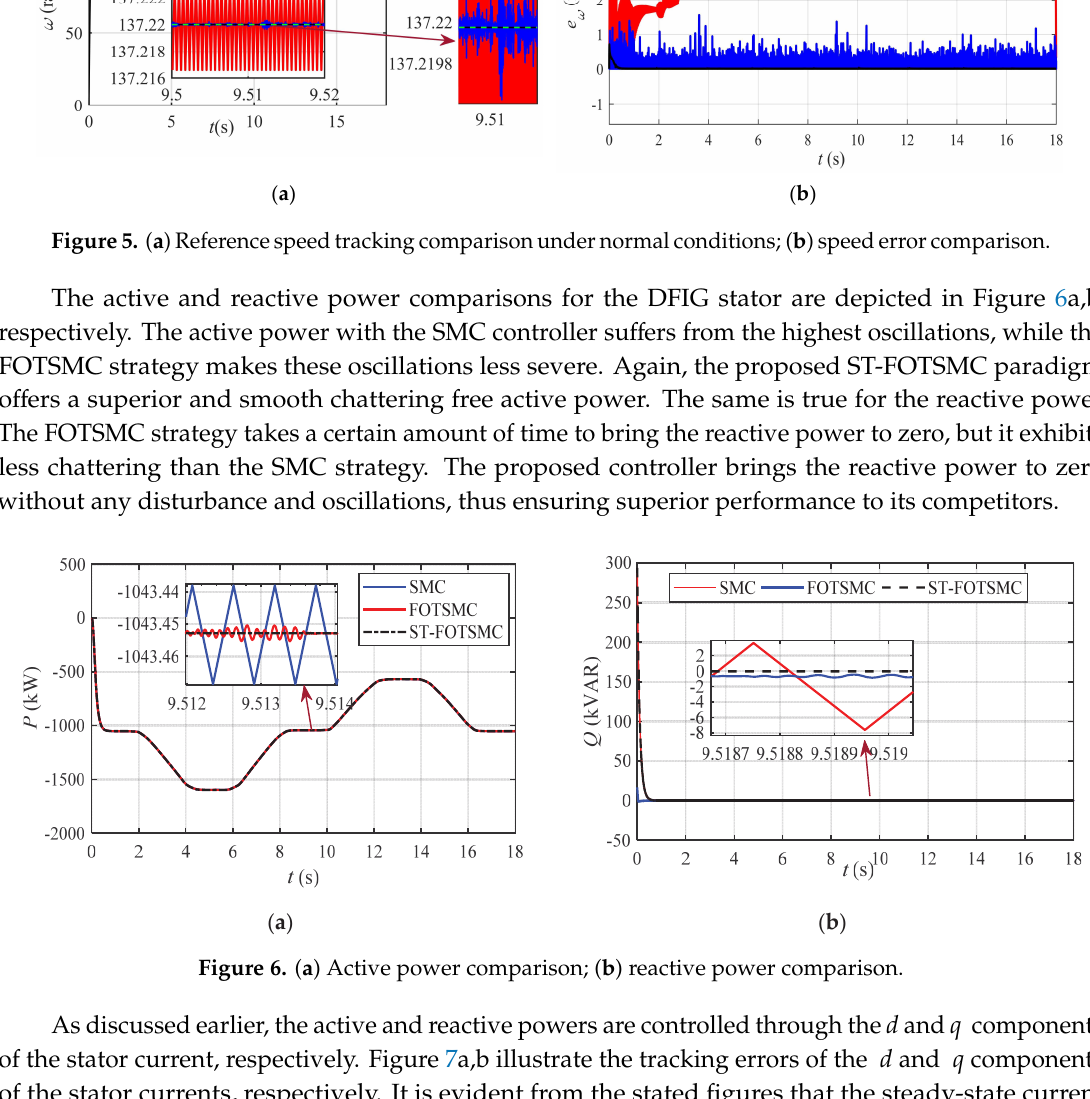
Figure (cid:561) 5. (cid:561) ( a ) (cid:561) Reference (cid:561) speed (cid:561) tracking (cid:561) comparison (cid:561) under (cid:561) normal (cid:561) conditions; (cid:561) ( b ) (cid:561) speed (cid:561) error (cid:561)